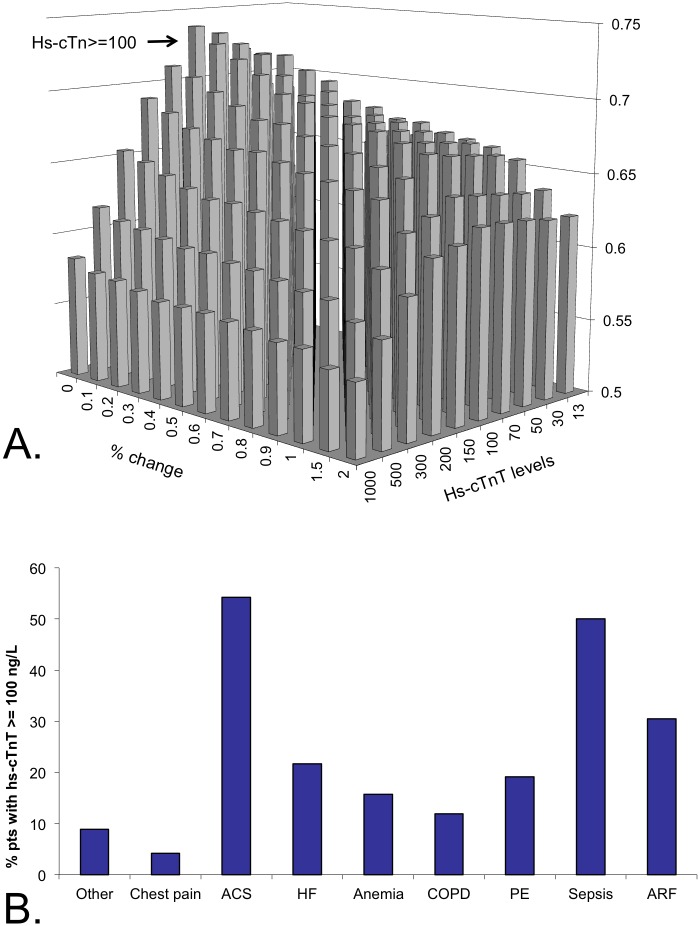
Optimization of maximal high sensitivity troponin and dynamic change to differentiate between ACS and other diagnoses.A graphic presentation of a goal-seeking algorithm assessing different cutoff values of high sensitivity troponin levels and dynamics between high sensitivity levels (A) and the percent of patients with elevated high sensitivity troponin > 100 ng/L (B).